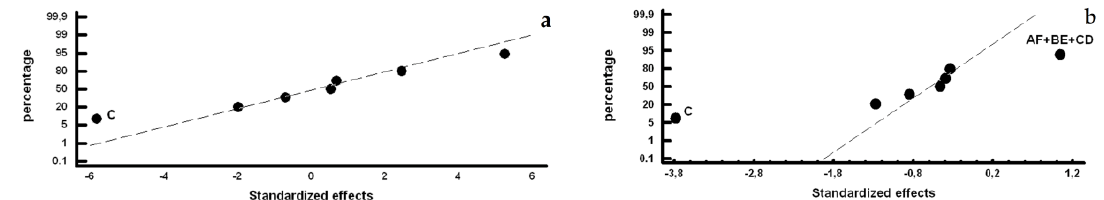
Figure 4. Representation of standardized effects on a normal probability plot versus the volume fraction of cementite, ( a ) Region I and ( b ) Region II.